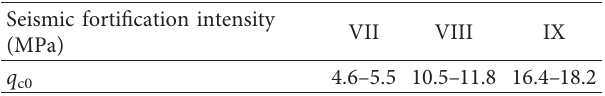
Table 7: Basic values of penetration resistance and cone tip re- sistance [22].